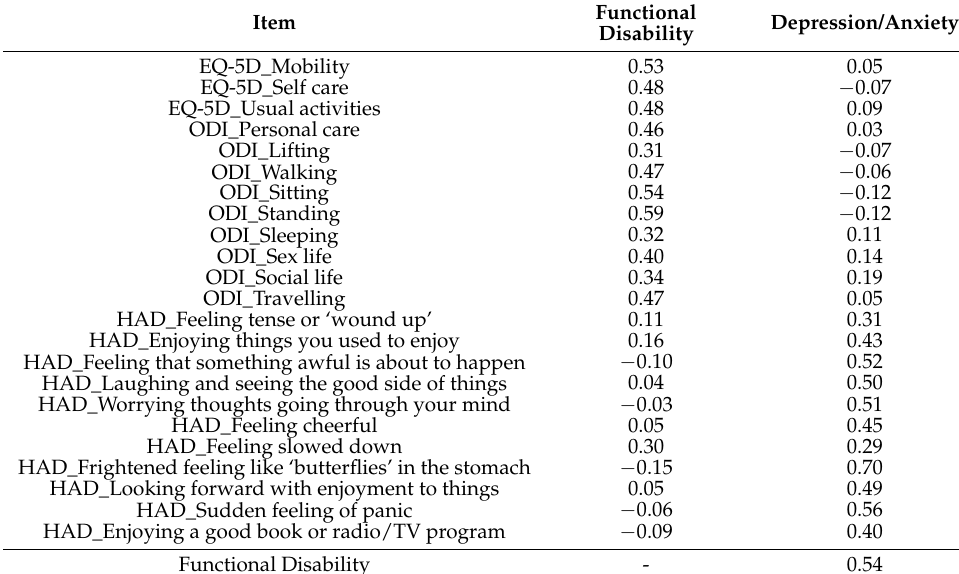
Table 1. Factor loadings and correlations between EFA-based